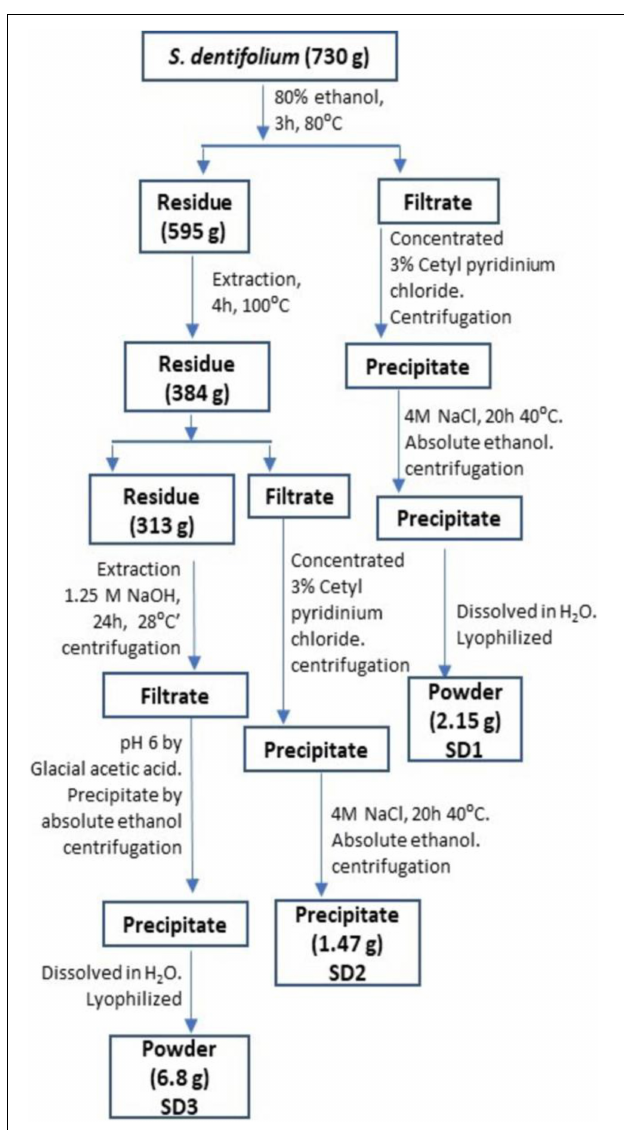
FIGURE 1 | A schematic presentation for extraction protocol and fractionation of S. dentifolium .